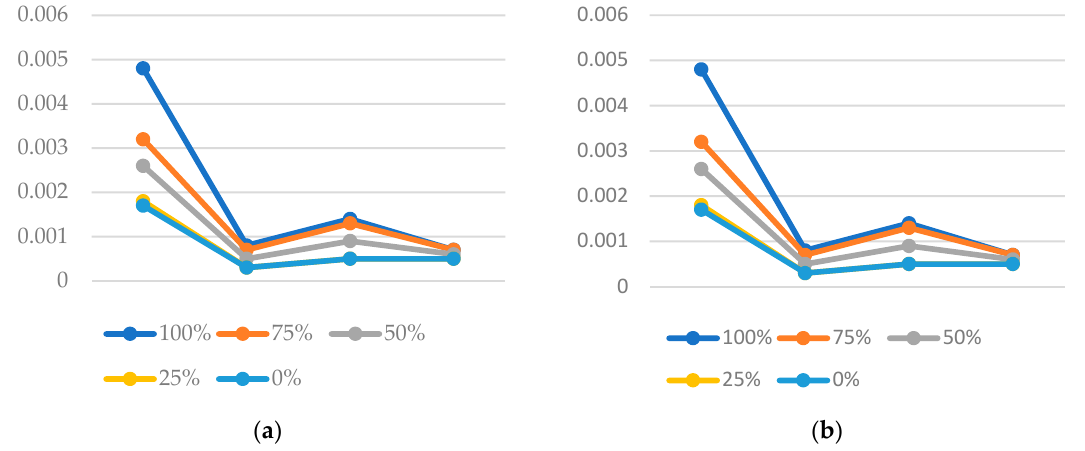
Figure 7. Highest frequency amplitudes between 5 kHz steps of X-axis ( a ) idle signal and ( b ) stroke signal.